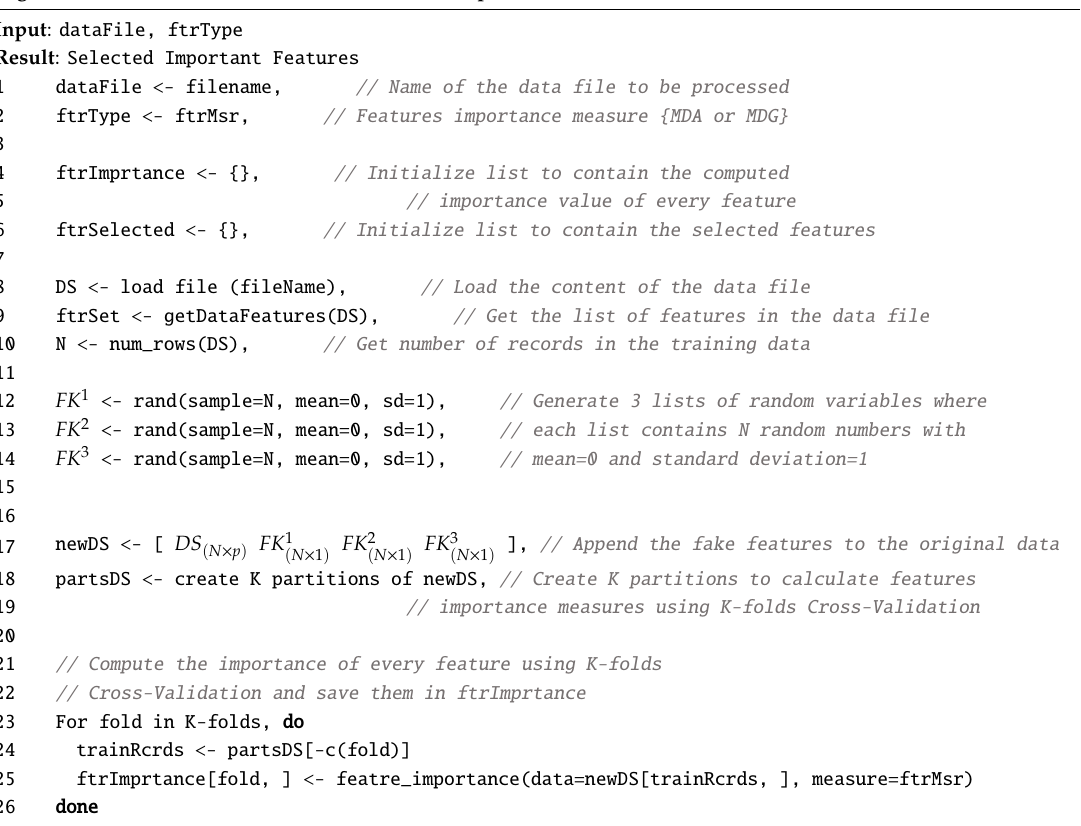
Algorithm 1: Feature Selection with Fake Features (pseudo